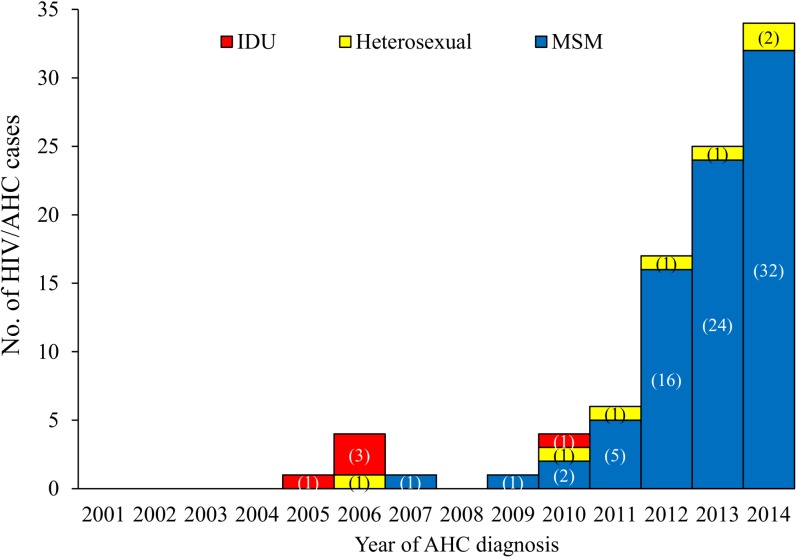
Trend of HIV/AHC cases by population at risk, Taiwan, 2001–2014.
aNumbers in parentheses indicate numbers of HIV/AHC cases in each risk category.